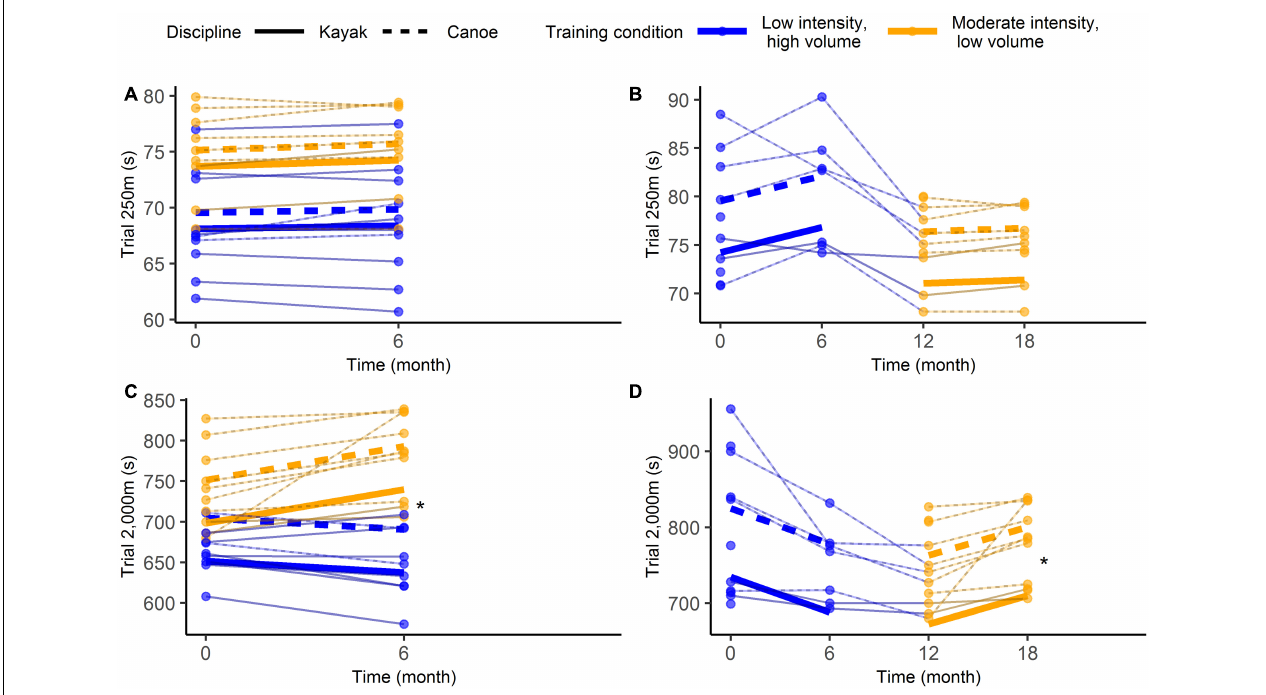
FIGURE 3 | Individual data (thin lines) and model estimates (thick lines) for on-water performance for the between-subject analyses (A,C) and the within-subject analyses (B,D) . Asterisks (*) flag significant